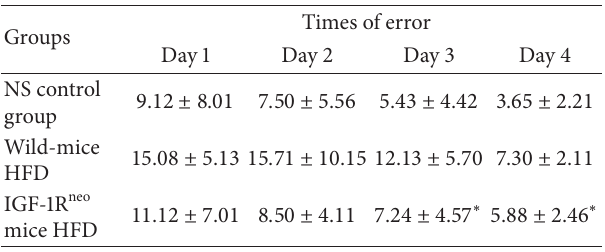
Table 2: The times of error in MS-2 water maze Automatic Control System